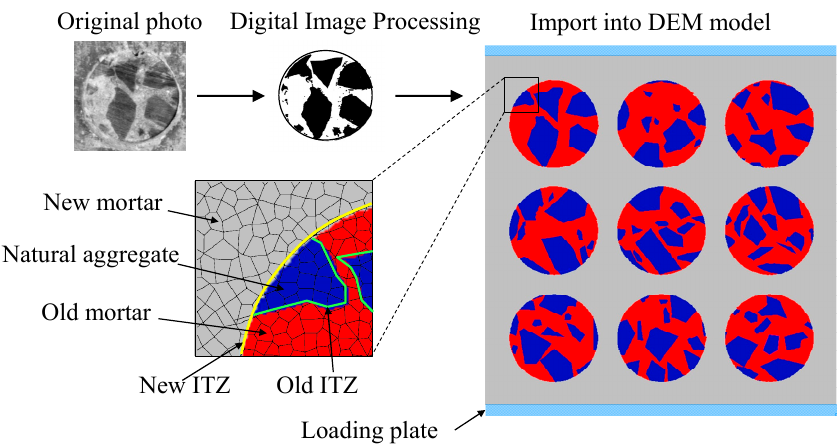
Figure 6. Image based meso-structure discrete element method (DEM) model of modeled recycled aggregate concrete (MRAC) specimen.